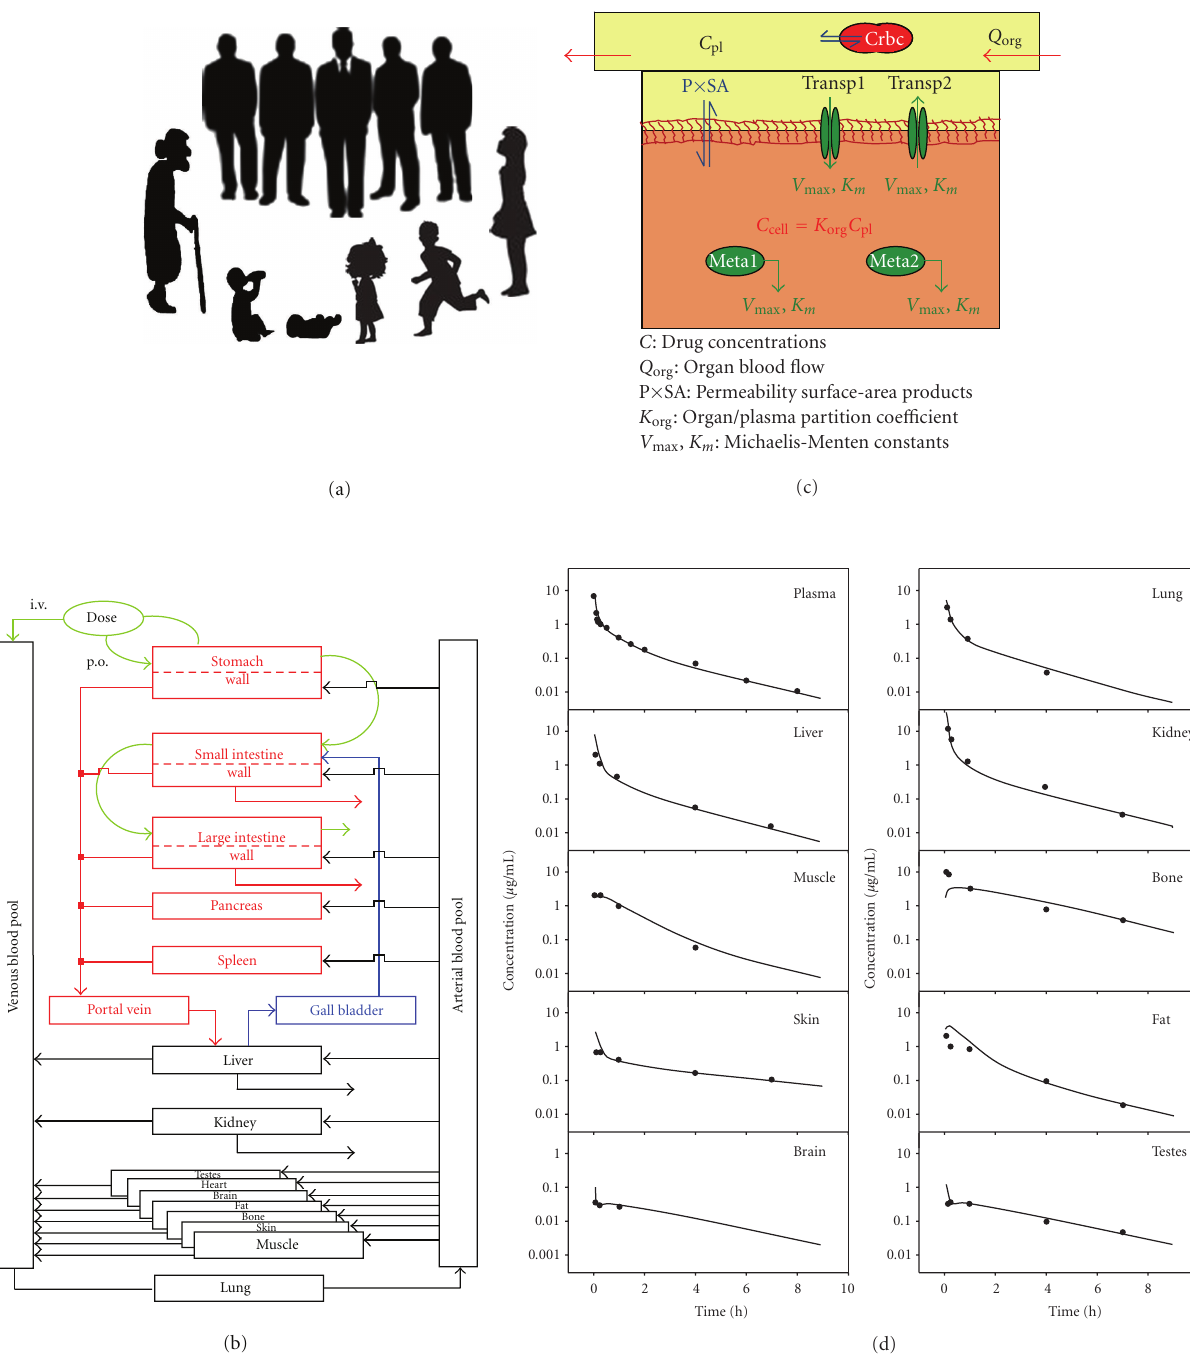
Figure 1: The concept for building a PBPK model modified according to Willmann et al. [13]. (a) Organisms (e.g., humans of di ff erent ages or populations) are the basis for the model. (b) The organism is divided into a number of compartments, each representing a single organ. To describe the distribution of compounds in the body, the organs are connected via their arteries and veins to the arterial and venous blood pool. Intercompartmental mass transport occurs via organ-specific blood flow rates. The organs are mathematically connected. (c) Division of each organ into three subcompartments representing the vascular space with blood cells and the interstitial and cellular space. The interstitial space is assumed to be in direct contact with the plasma. The exchange of substances between the cellular and interstitial compartment can occur by permeation across the membranes via passive di ff usion as well as active influx and e ffl ux transport processes by saturable Michaelis-Menten (MM) kinetics with V max and K m as parameters. Metabolism of substances (Meta1 and Meta2) occurs via active enzymes (MM kinetics). Finally, the model consists of a large number of coupled di ff erential equations. (d) Output of the model: concentration time curves for the substances shown are simulated and observed ciprofloxacin concentrations in various organs after ciprofloxacin 5mg/kg was intravenously applied to a